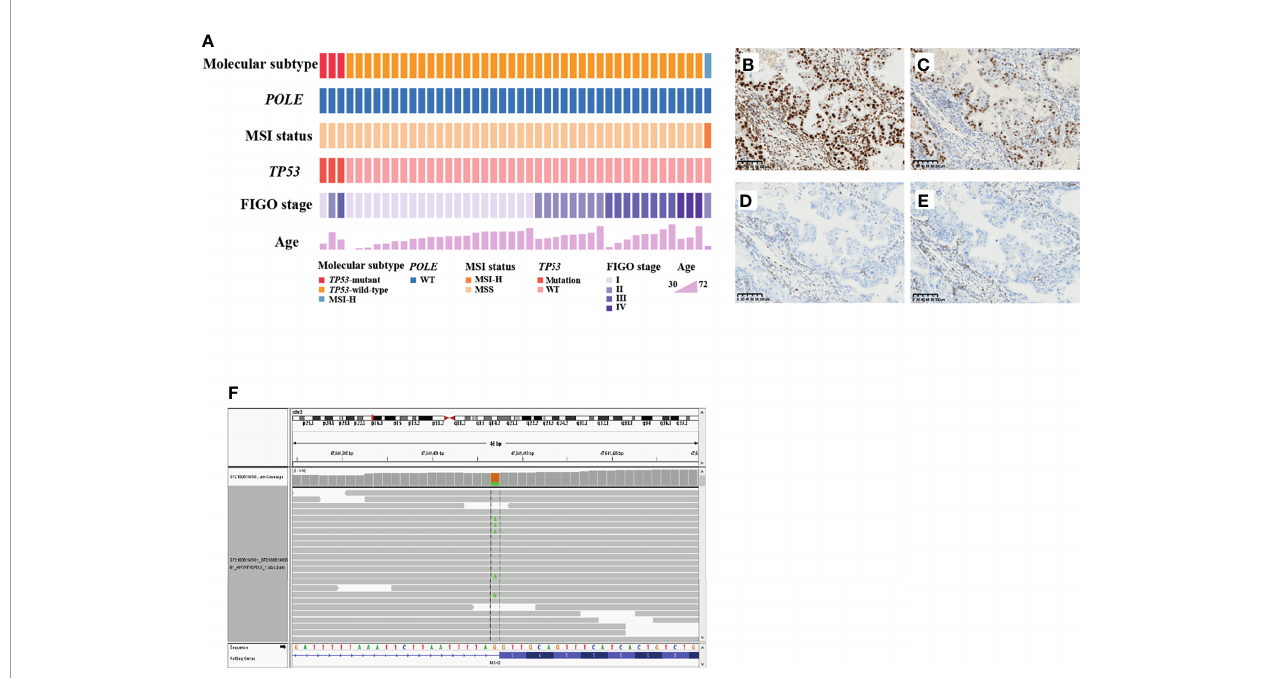
FIGURE 3 | TP53 mutation, POLE mutation, and MSI status in patients with OCCC. (A) Tumors were strati fi ed into three groups: TP53 -wild-type subgroup, TP53 - mutant subgroup and microsatellite instability-high (MSI)-H subgroup. The MSI-H case showed intact expression of MLH1 (B) and PMS2 (C) , but loss of MSH2 (D) or MSH6 (E) expression. Positively staining stromal cells were seen in the background as an internal control. (F) Lynch syndrome was con fi rmed by the presence of MSH2 pathogenic germline variant in the MSI-H